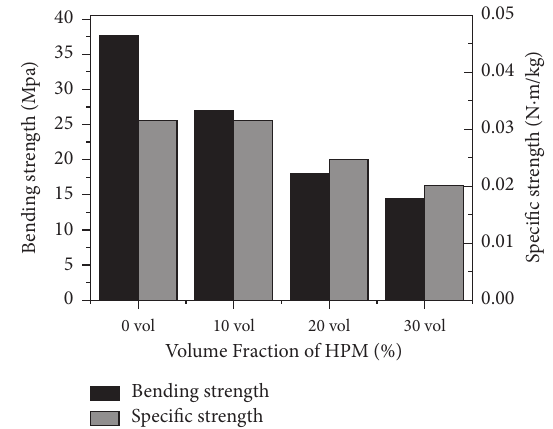
Figure 6: Flexural strength and specific strength of HPM/phenolic syntactic